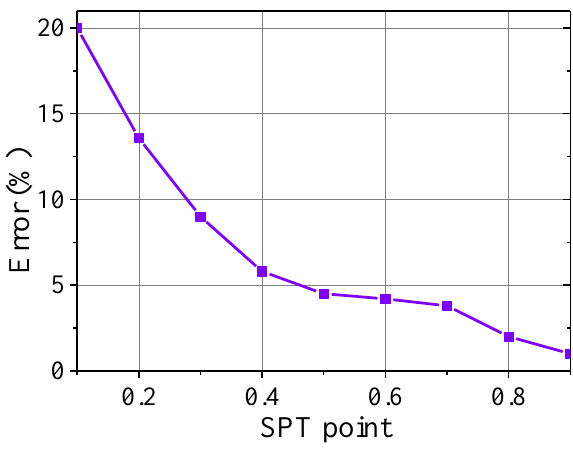
ff erent starting prediction time (SPT) Figure 2. Prediction error under different starting prediction time (SPT) selection. Figure 2. Prediction error under di